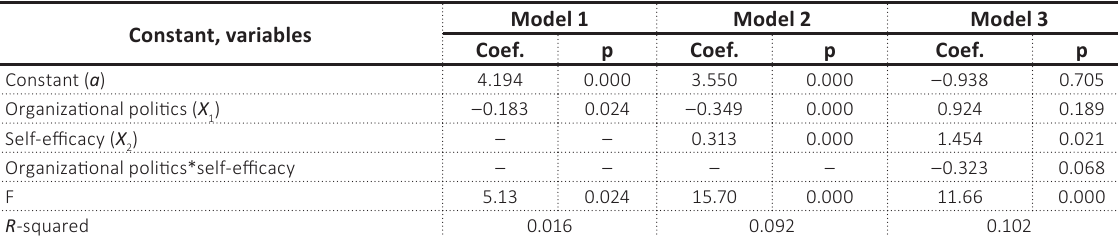
Source: Results of the analysis by STATA